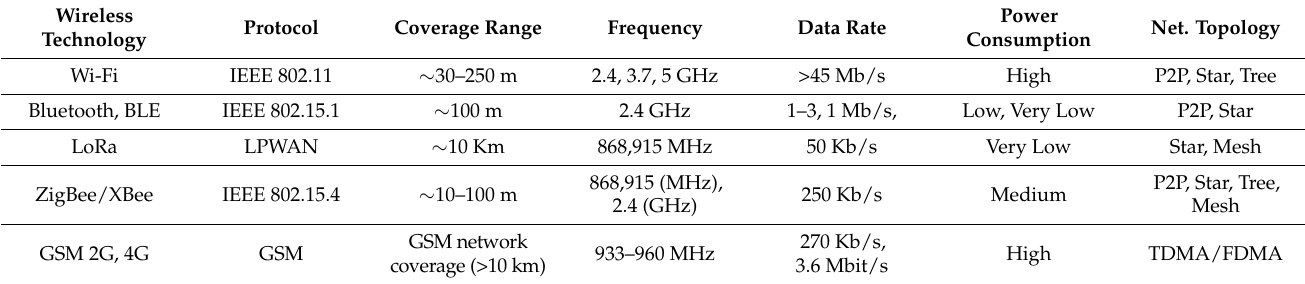
Table 1. Wireless communication technologies are used in hazardous gases mobile detection and alarming systems. Wireless